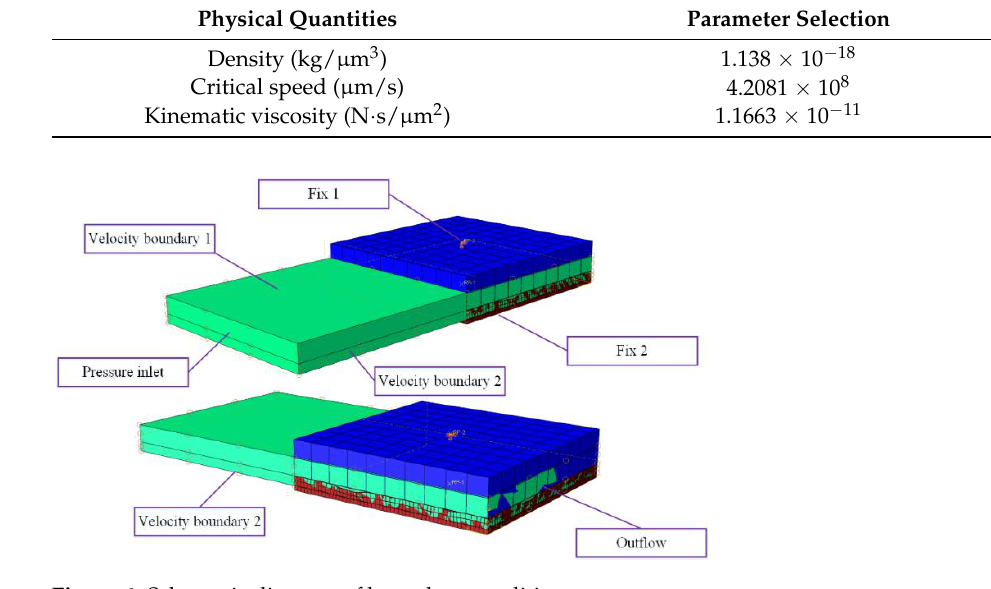
Figure 6. Schematic diagram of boundary conditions. Table 2. Physical parameters of nitrogen.